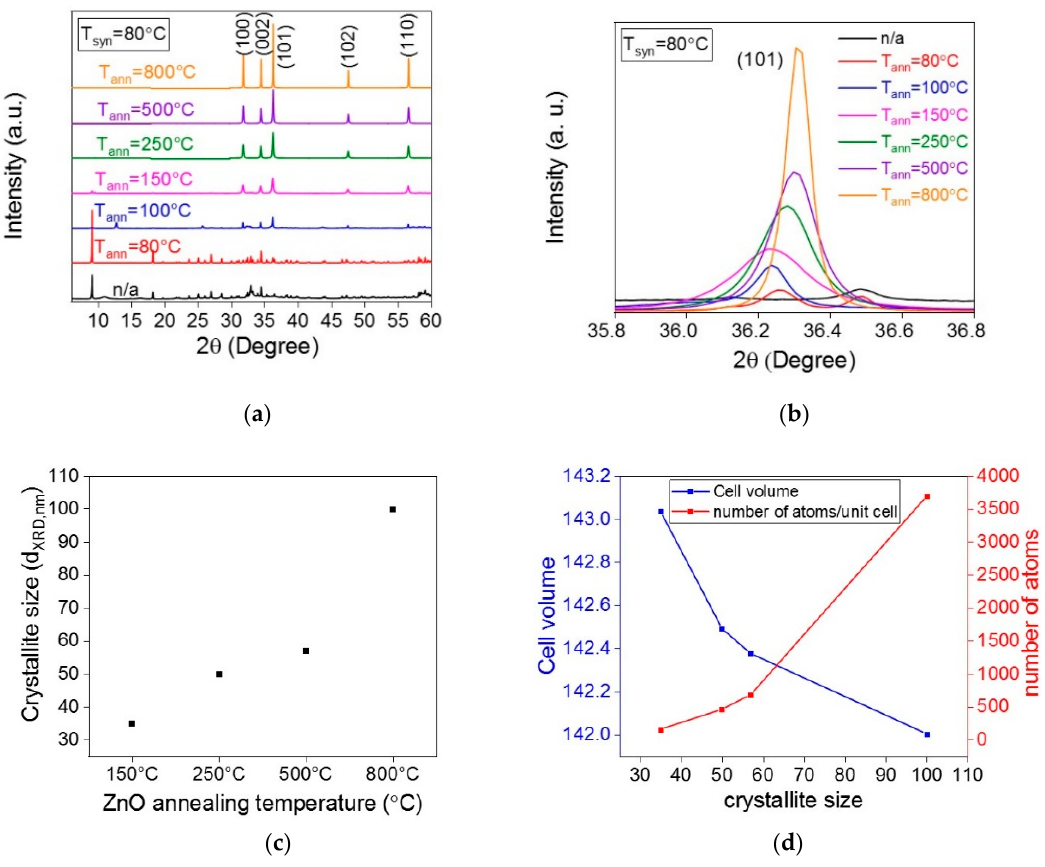
Figure 3. XRD measurements of the powdered ZnO nanoparticles (NP) synthesized at 80 °C and annealed at different temperatures: ( a ) XRD patterns, ( b ) the variation of the (101) plane peak intensity and position with increasing the annealing temperatures, ( c ) the evolution of the crystallite size as a function of annealing temperature, ( d ) the illustration of the variation of the cell volume and number of atoms per unit cell as a function of crystallite size.